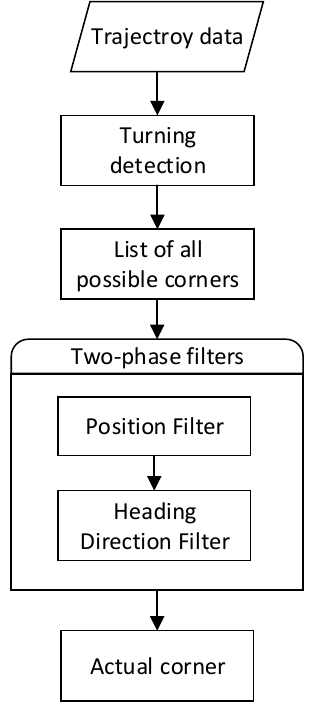
Figure 6. Flow chart of a corner-matching algorithm.